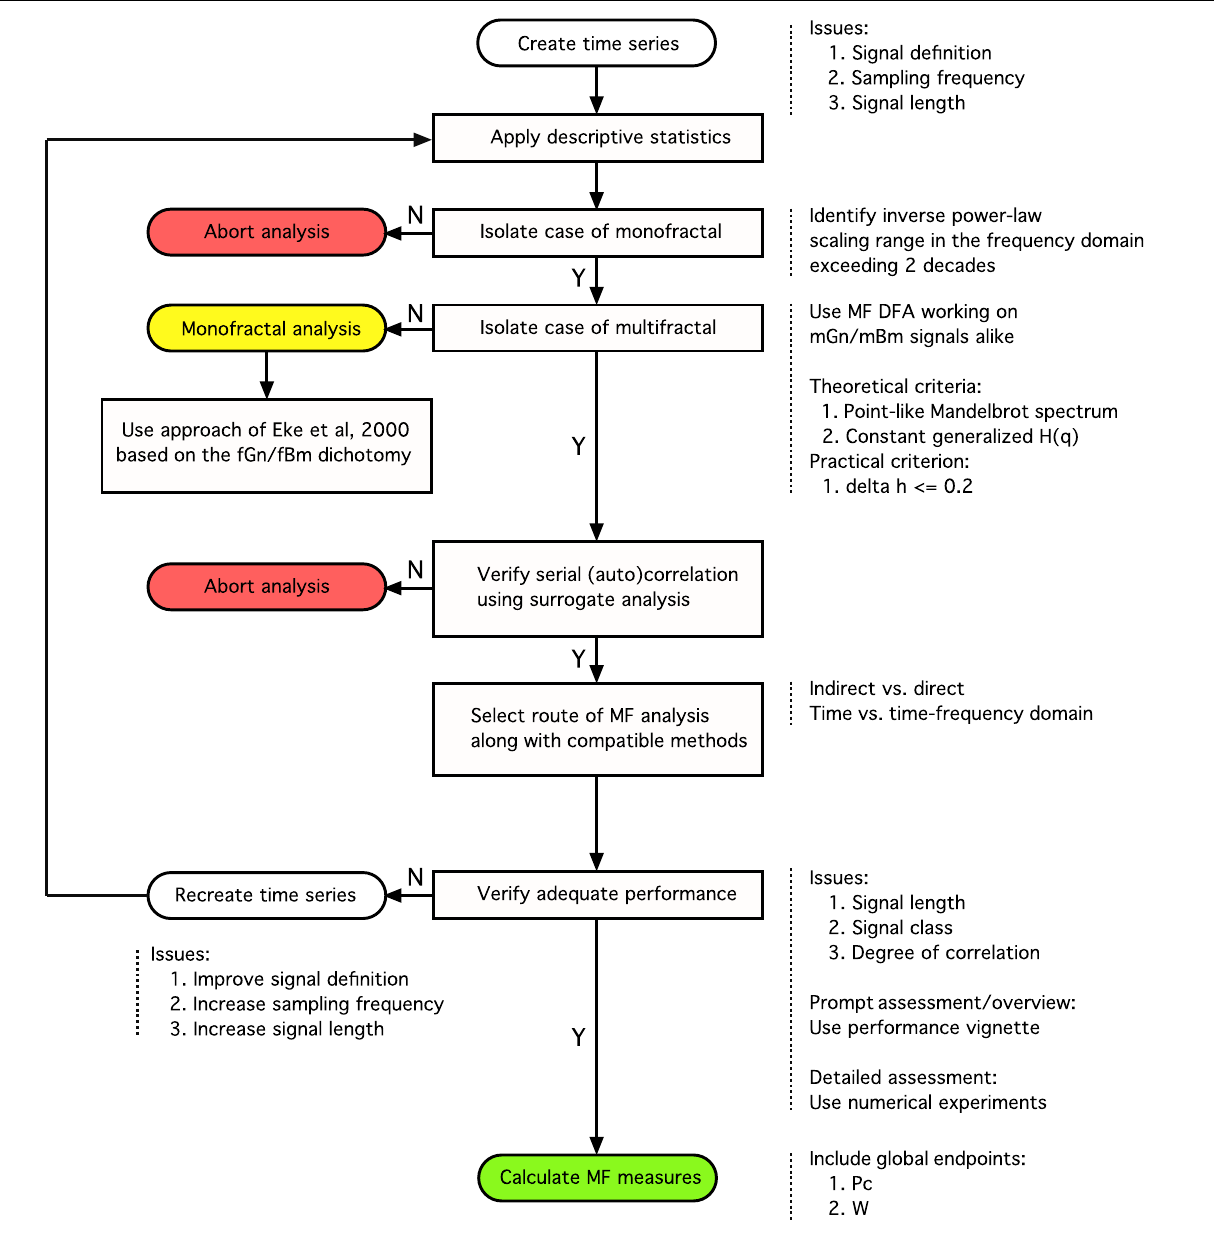
FIGURE 8 |Analytical strategy for fractal time series analysis. Toward obtaining a reliable (multi)fractal parameter, which is the purpose of the analysis, the first step to take is to collect a high definition dataset representing the temporal signal, X ( t ), ensuring adequate